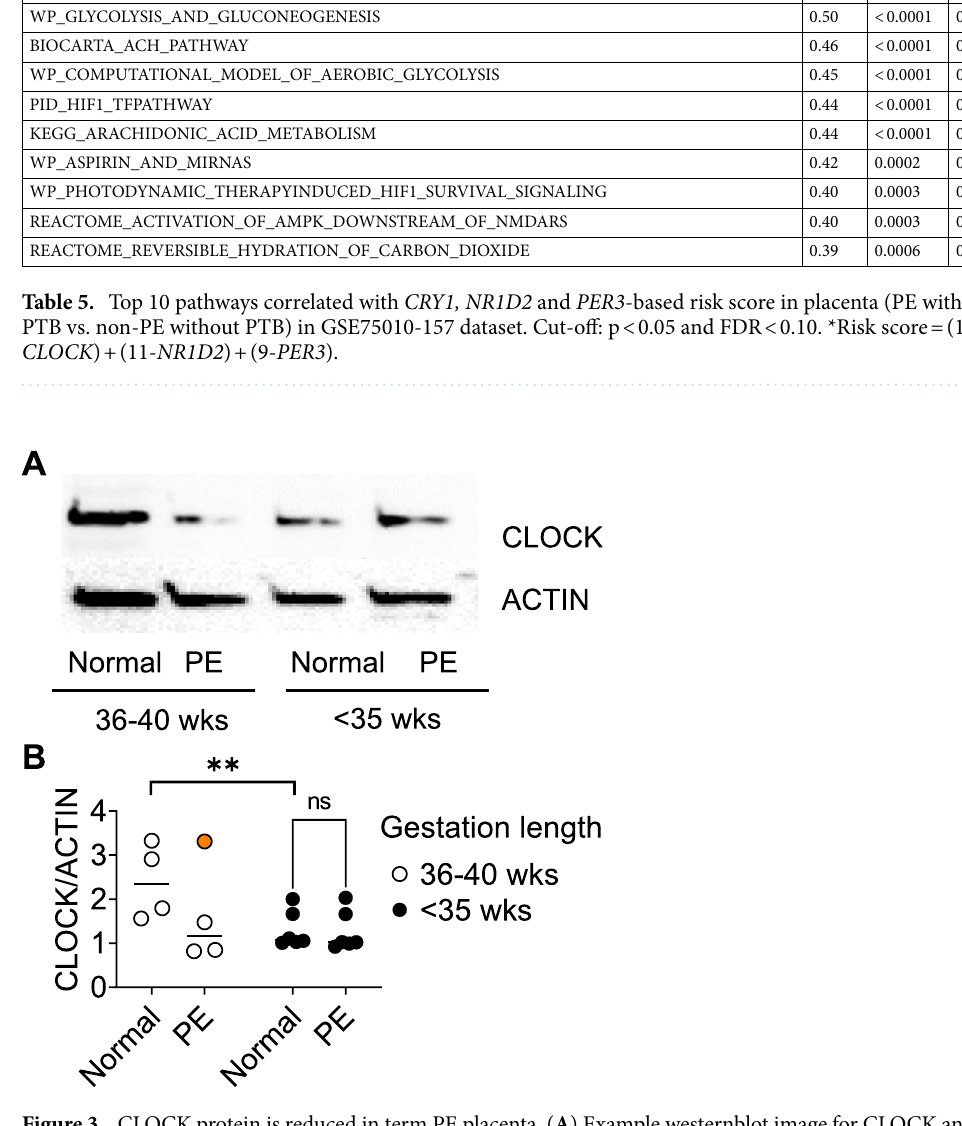
Figure 3. CLOCK protein is reduced in term PE placenta. ( A ) Example westernblot image for CLOCK and beta-ACTIN (ACTIN), of indicated human placenta samples. ( B ) Histogram of CLOCK/ACTIN in human placenta. Each dot represents a sample. Two-way ANOVA, **, p < 0.001. n = 3–6/group. Sample labeled in orange was an outlier and excluded from statistical